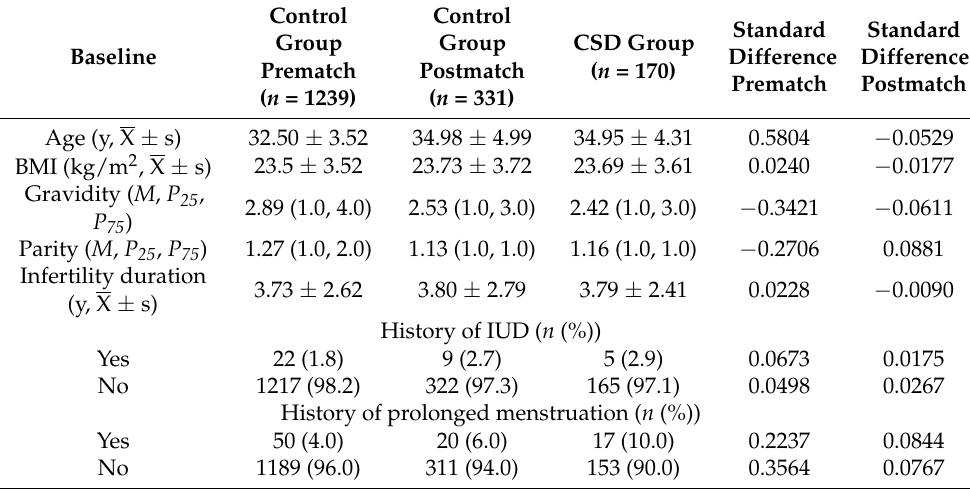
Figure 2. Study flow-chart. Note: CSD–cesarean scar defect; CE–chronic endometritis. Table 1 compares the baseline characteristics before and after matching. The absolute values of the SMD for each index before matching ranged from 0.0240–0.5804. The absolute values of the SMD after matching were all controlled within 10%. All baseline variables were more balanced after PSM (Figure 3). Table 1. Baseline characteristics before and after propensity score